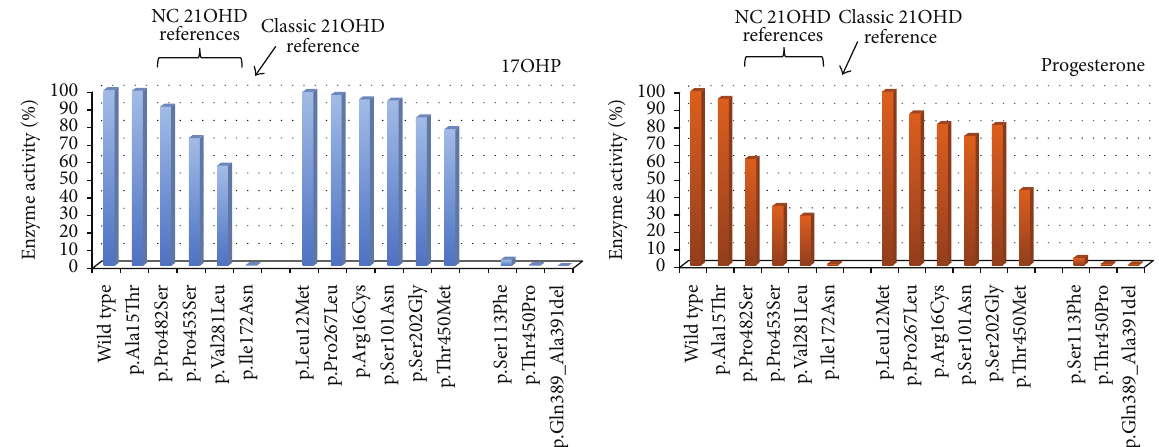
Figure 1: Enzymatic activities of CYP21A2 mutant proteins. Activities are expressed as a percentage of wild-type activity, which is arbitrarily defined as 100%. Conversion values are shown for the two natural substrates (17OHP and progesterone).